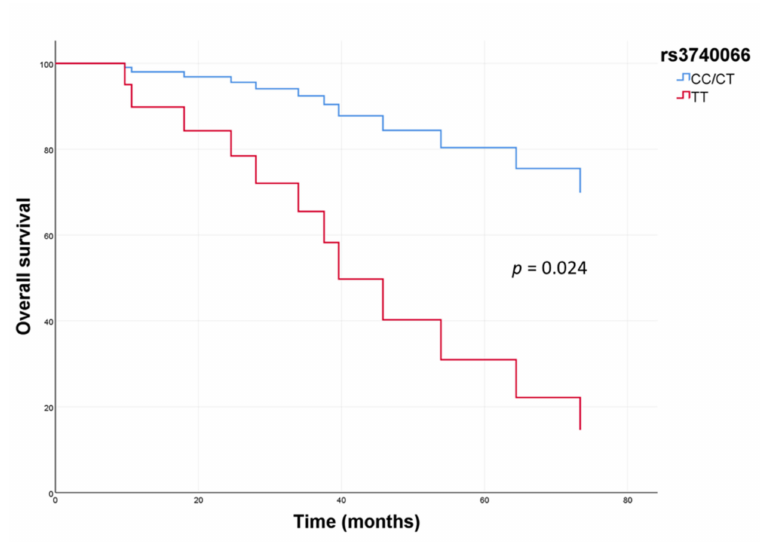
Figure 1. Overall survival according to ABCC2 rs3740066 variant in patients treated with anthracy- clines (multivariate